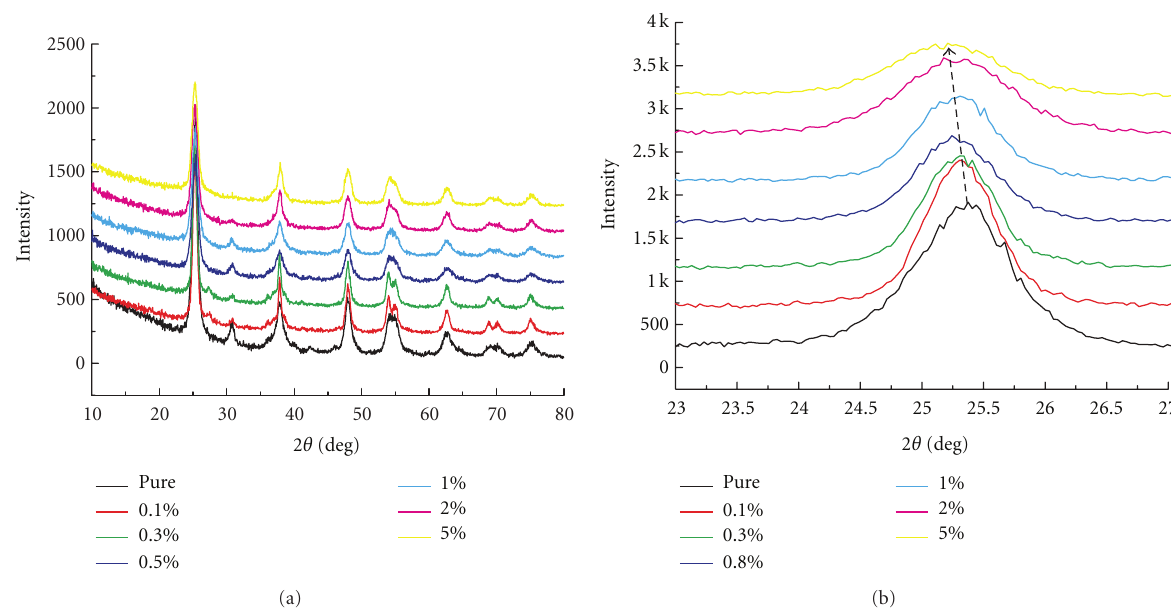
Figure 1: (A) The XRD patterns of the Fe-doped TiO 2 samples and (B) the magnified XRD (101)